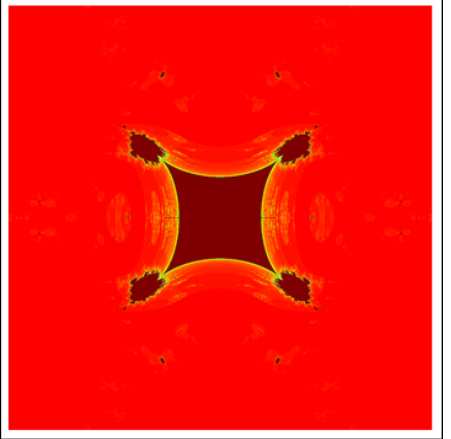
Figure 57. Multi-corn via F-iteration with image visual time = 145.9 s.